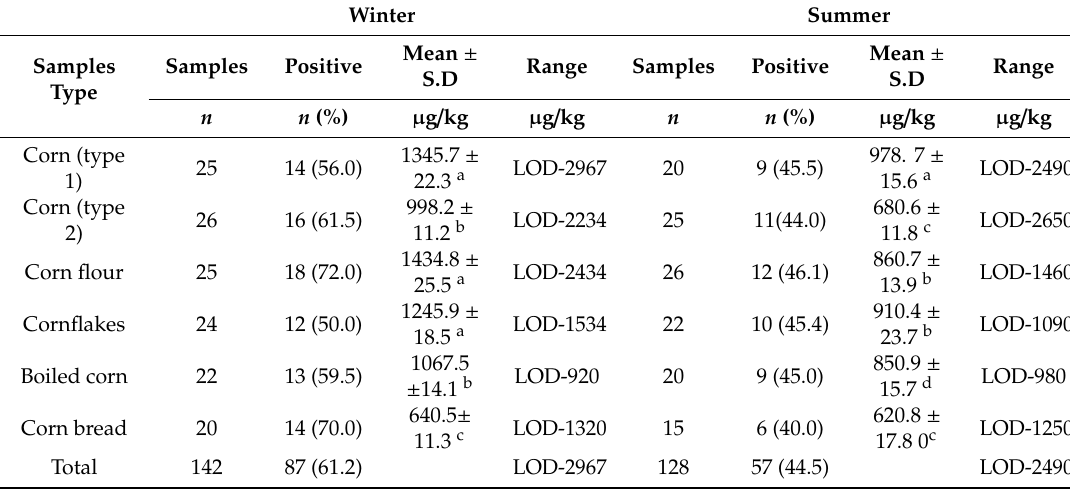
Table 3. Incidence and occurrence of DON in corn and products from summer and winter seasons from di ff erent cities of Punjab,